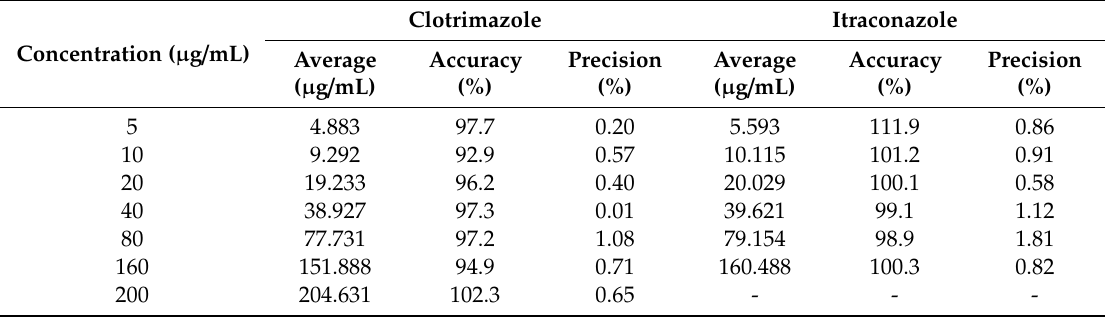
Table 2. Data related to the linearity of the developed HPLC method with its respective average, precision, and